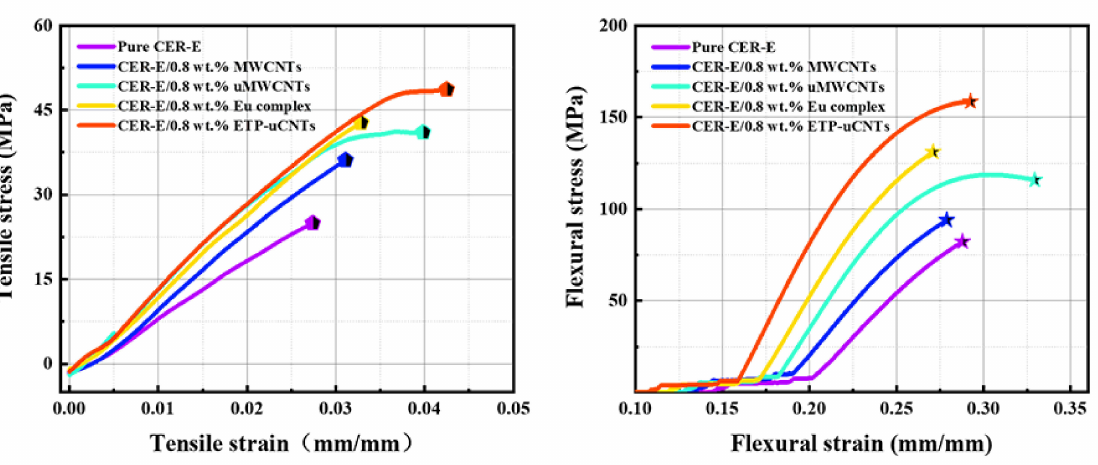
Figure 5. Stress–strain curves in tensile strength ( a ) and flexural strength ( b ) for pure CER-E, CER- E/MWCNTs, CER-E/uMWCNTs, CER-E/Eu complex, CER-E/ETP-uCNTs containing 0.8 wt.% of the